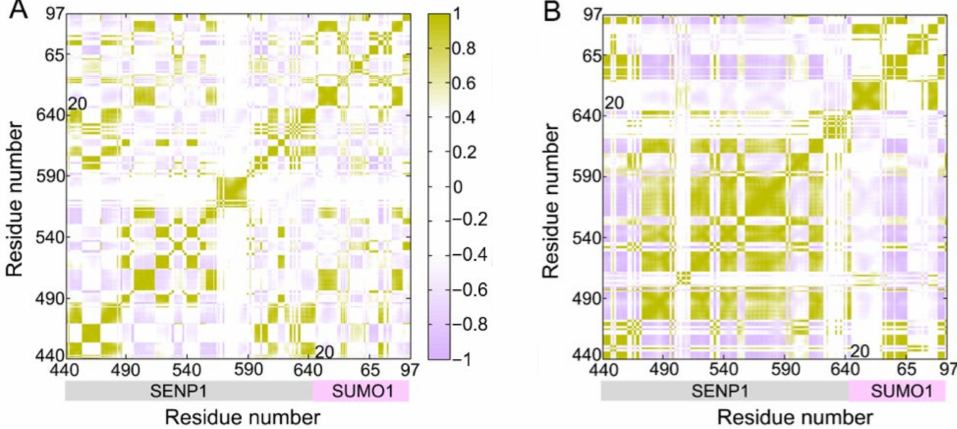
Figure 4. Dynamic cross-correlation matrix (CC ij ) for the WT ( A ) and Q597A ( B ) mutant systems. The correlated motions are colored green-yellow (CC ij > 0), while the anti-correlated motions are colored purple (CC ij < 0). Color scales are shown to the right. The CC ij values with an absolute correlation coefficient of <0.4 are colored white for